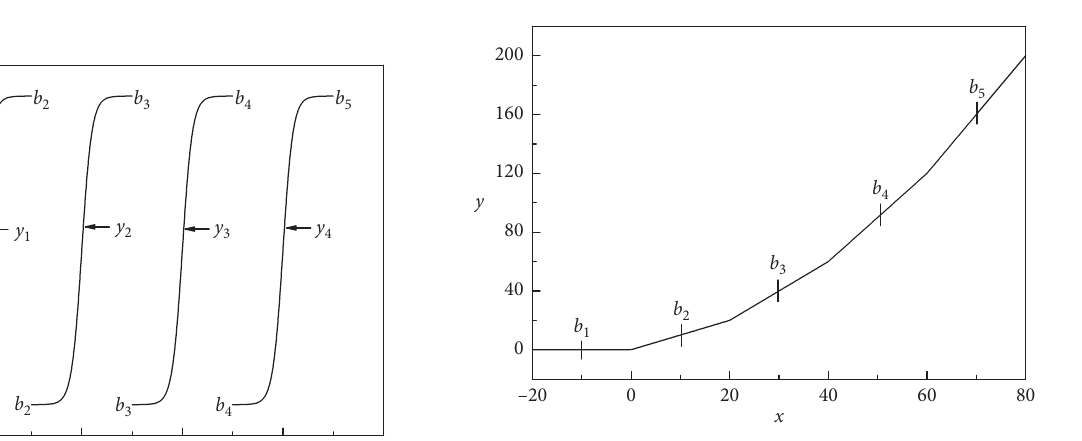
Figure 7: Schematic diagram of the slip surface based on the logistic function.